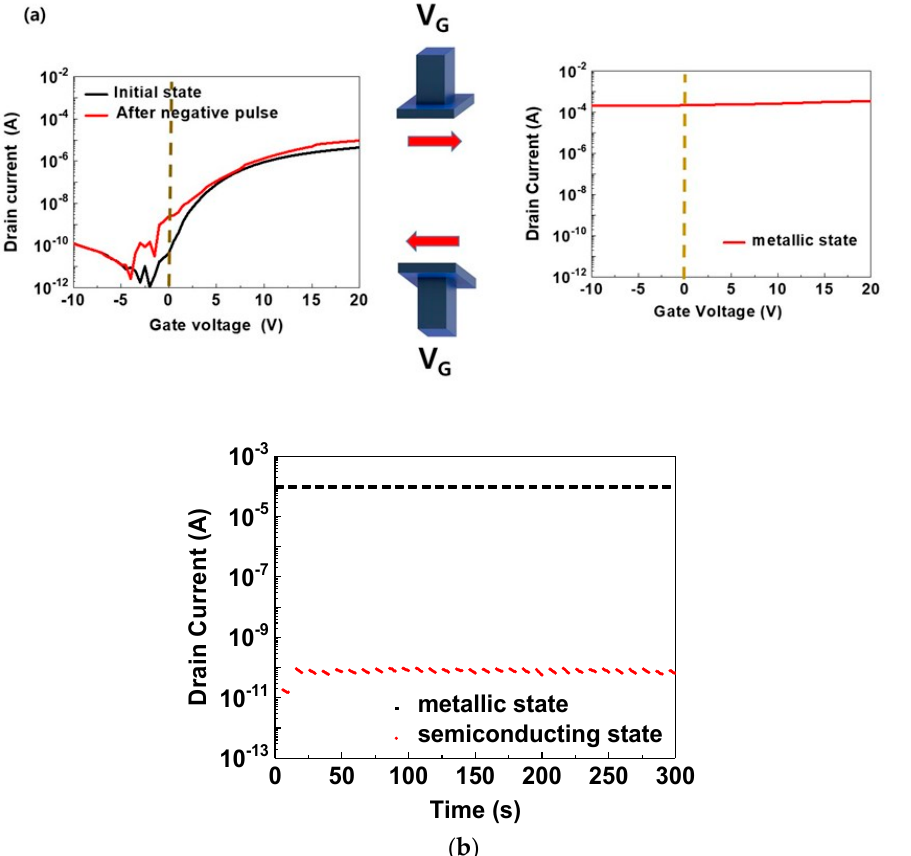
Figure 2. Characteristics of MST devices employing a CID with W / L = 40/30 μ m fabricated on Si ( n ++ ) substrates. ( a ) Transfer curves of semiconducting and metallic states and gate voltage pulses for state conversion. ( b ) Variation in drain current for repeated switching of gate voltage polarity at V G = 0 V.